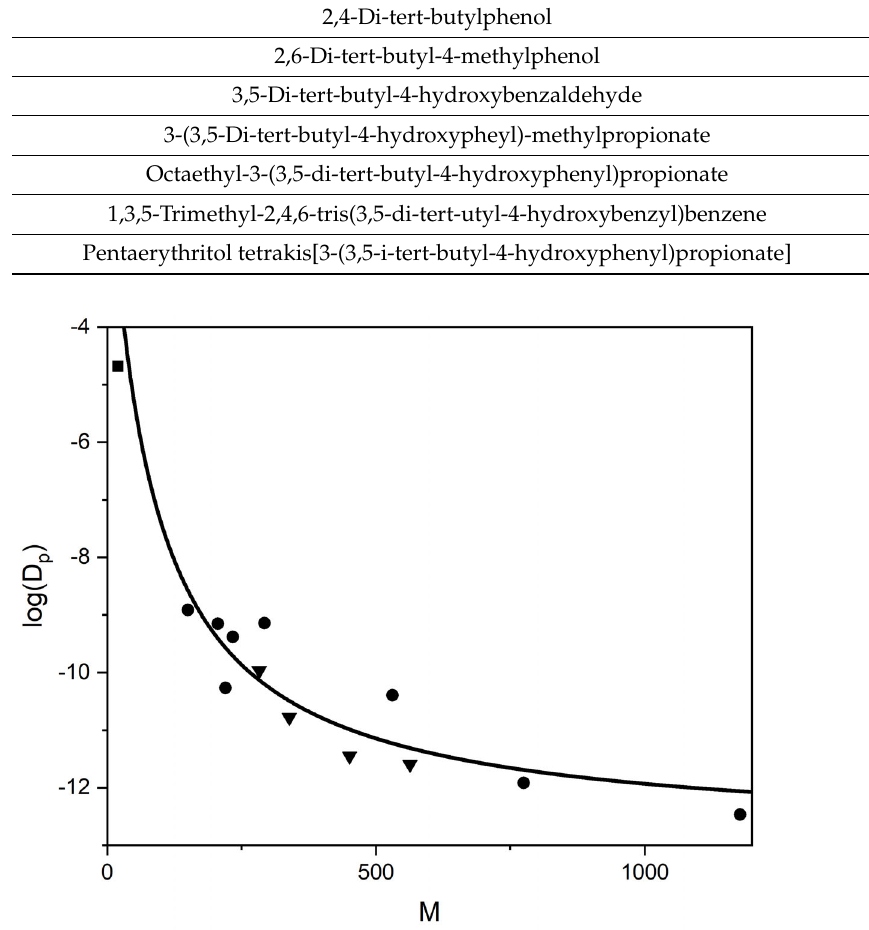
Figure 12. Diffusion coefficients in HDPE at 60 °C. ( ● ) Compounds from Table 8 [44]; ( ▼ ) n ‐ alkanes with 20, 27, 32 and 40 carbon atoms [6]; ( ■ ) water